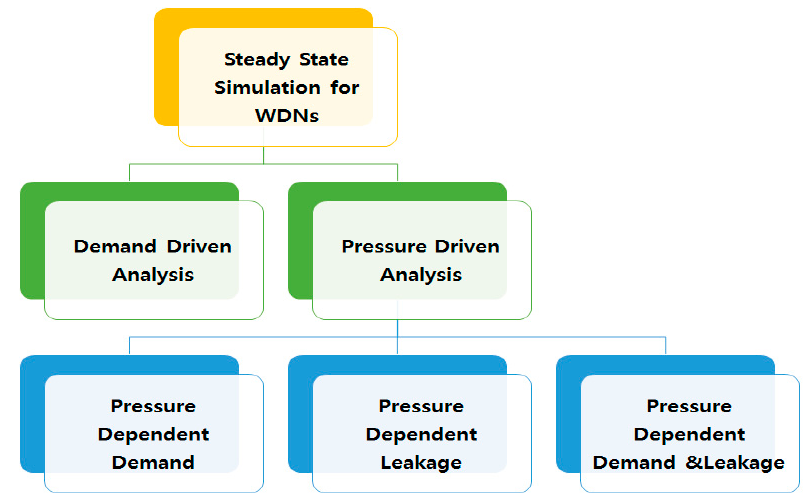
Figure 1. Steady flow pipe network analysis technique classification system reflecting the newest technology.